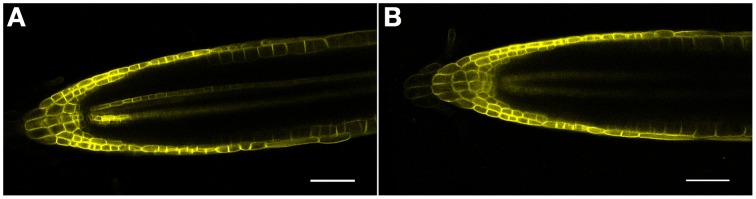
(A,B) AUX1 (AUX1-YFP) confocal microscopic localization in roots, ± salt. (A) Control root; note reporter expression in both the epidermis and vascular tissue. (B) Root treated with 150 mM salt for 6 h. Note the loss of AUX1 expression in the central vascular tissue as well as a diminishment in expression in both the QC and RC. Scale bar = 50 μm, n = 4 roots for control and eight roots for each treatment.